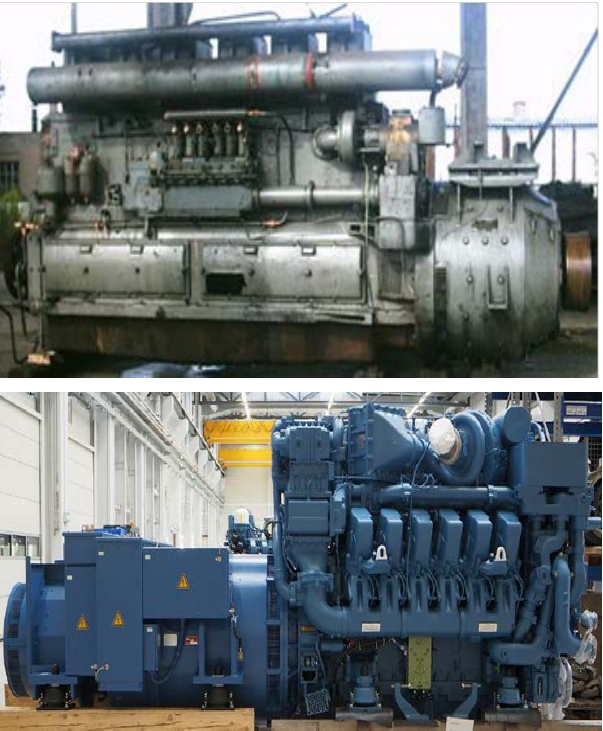
Fig. 9. View: top – generator set with engine type PD1M (before moderni- zation) and bottom – generator set with engine type MTU 12V4000R84 (after modernization)